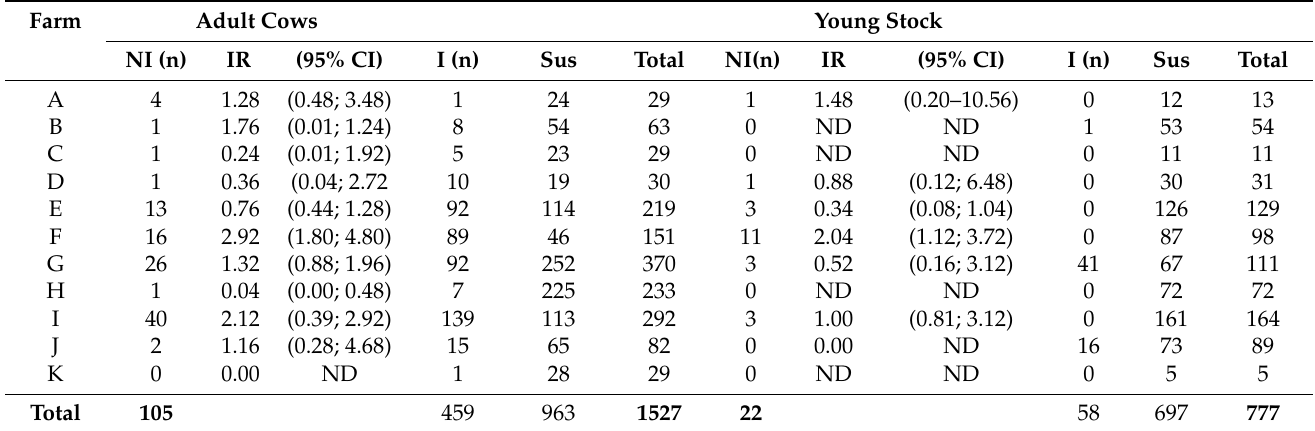
Table 1. Incidence rate (expressed in infections per 100 animal-month at risk) and its 95% confidence interval of BLV infections, for the groups Adult Cows and Young Animals, by Farm.